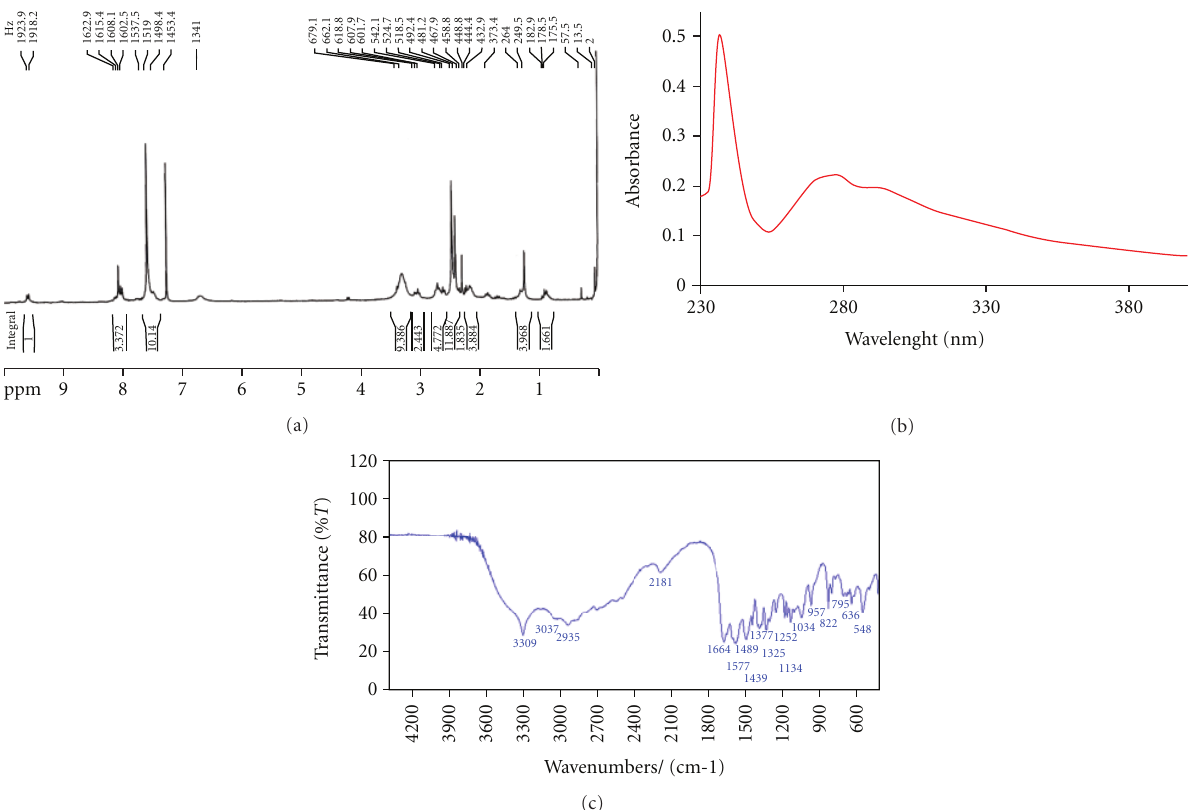
Figure 2: (a) 1 H NMR spectrum, (b) UV-vis spectrum, and (c) FT-IR spectrum of the platinum complex.